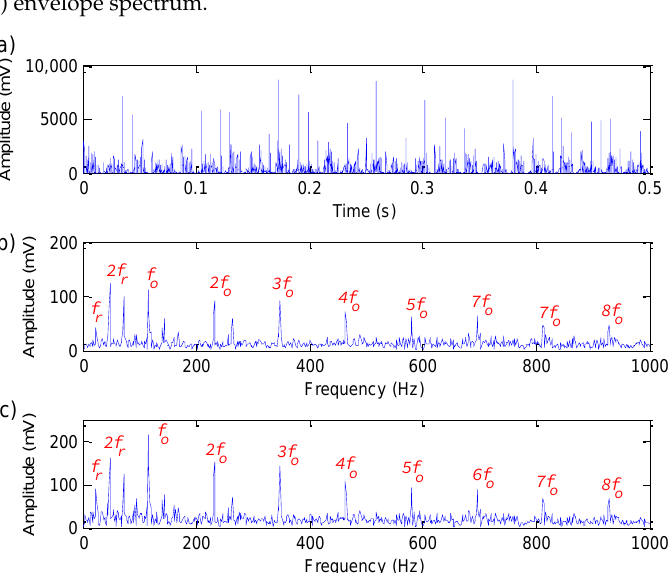
Figure 13. Analysis results obtained by the proposed method for bearing outer race fault signal: ( a ) Time domain waveform; ( b ) amplitude spectrum; ( c ) envelope spectrum.